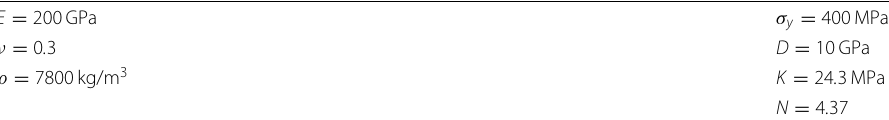
Table 1 Material